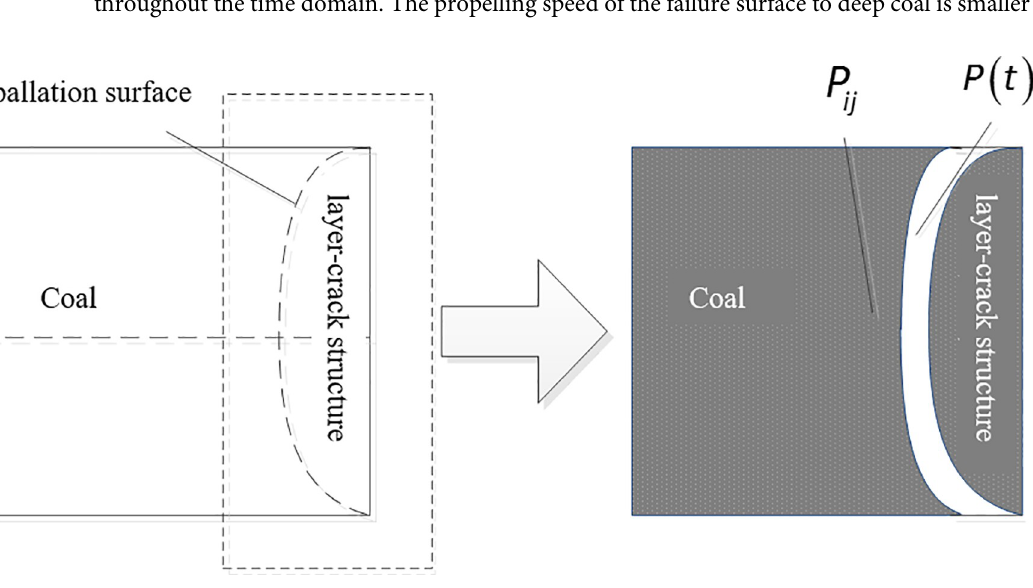
Fig 12. Schematic diagram of the initial spallation of